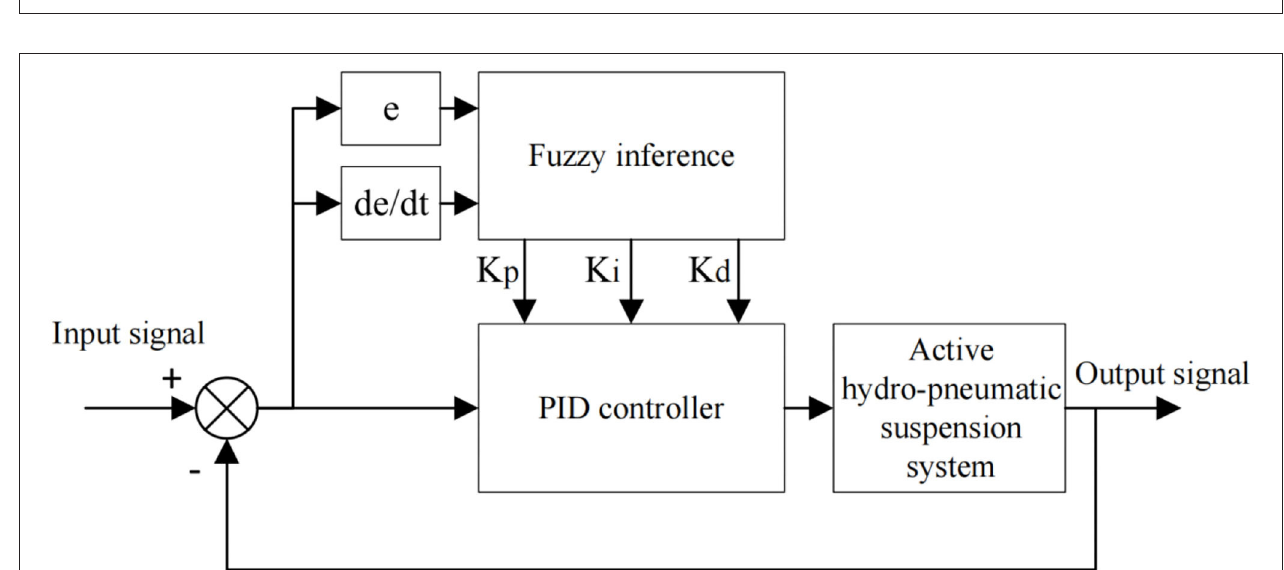
FIGURE 2 | Active hydro-pneumatic suspension control scheme.